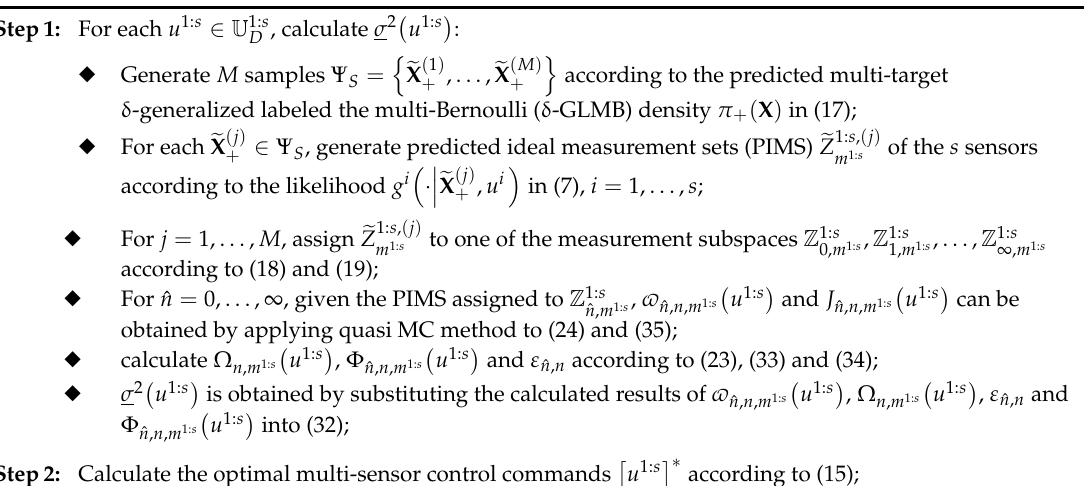
Table 1. Recursion for constrained multi-sensor control and multi-target tracking